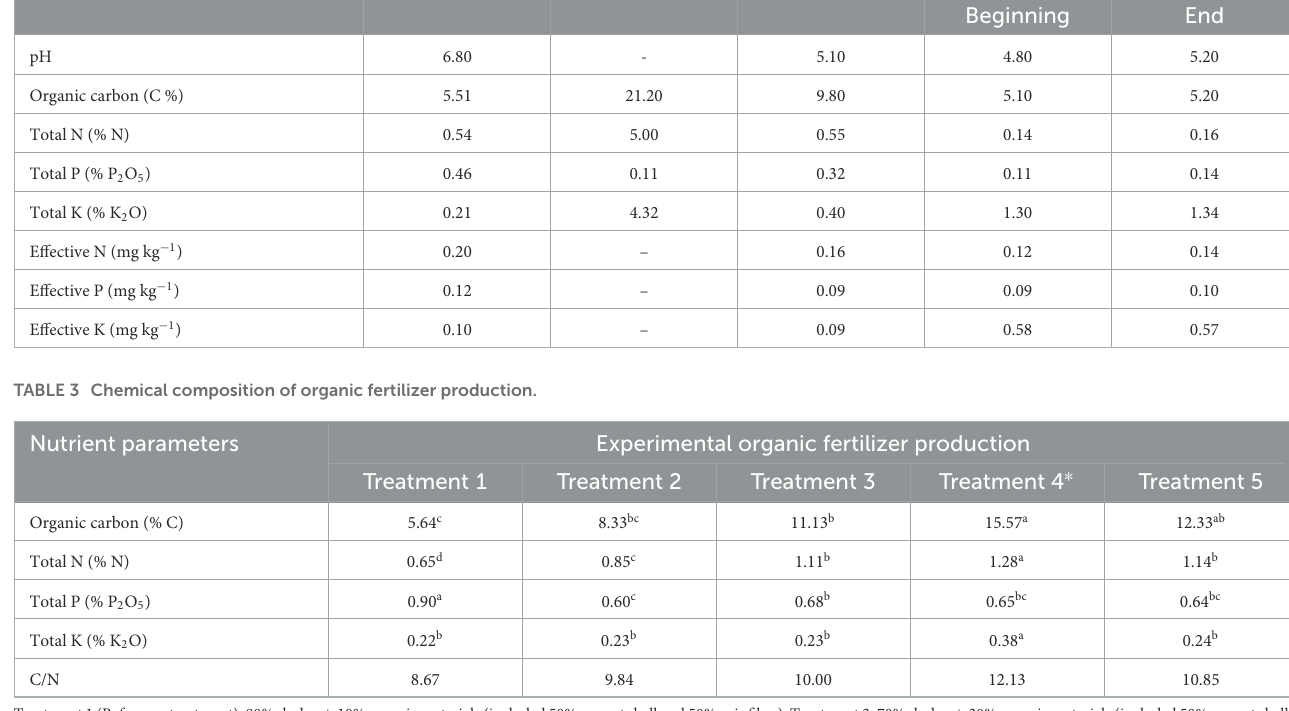
TABLE 2 Chemical composition of sludge from snakehead fish ( Channa striata Bloch, 1973) pond, agricultural organic amendments, and organic fertilizer production. Nutrient parameters